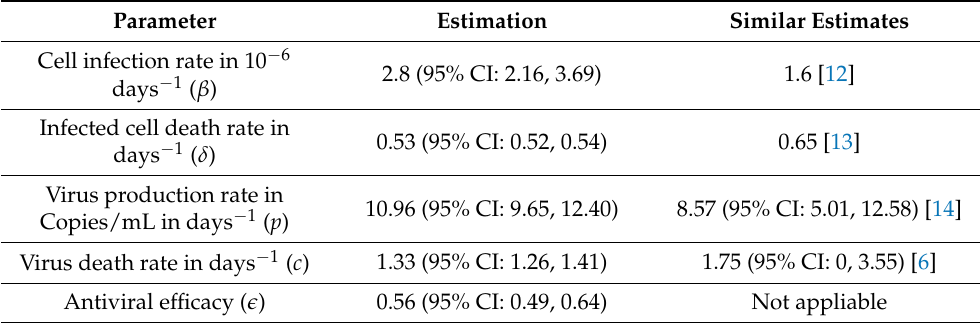
Table 1. Within-host parameter estimates. We fitted the within-host model to the mean viral load dynamics of 1433 infected adults [3] by using nonlinear mixed-effects model method [11] to infer the parameters.